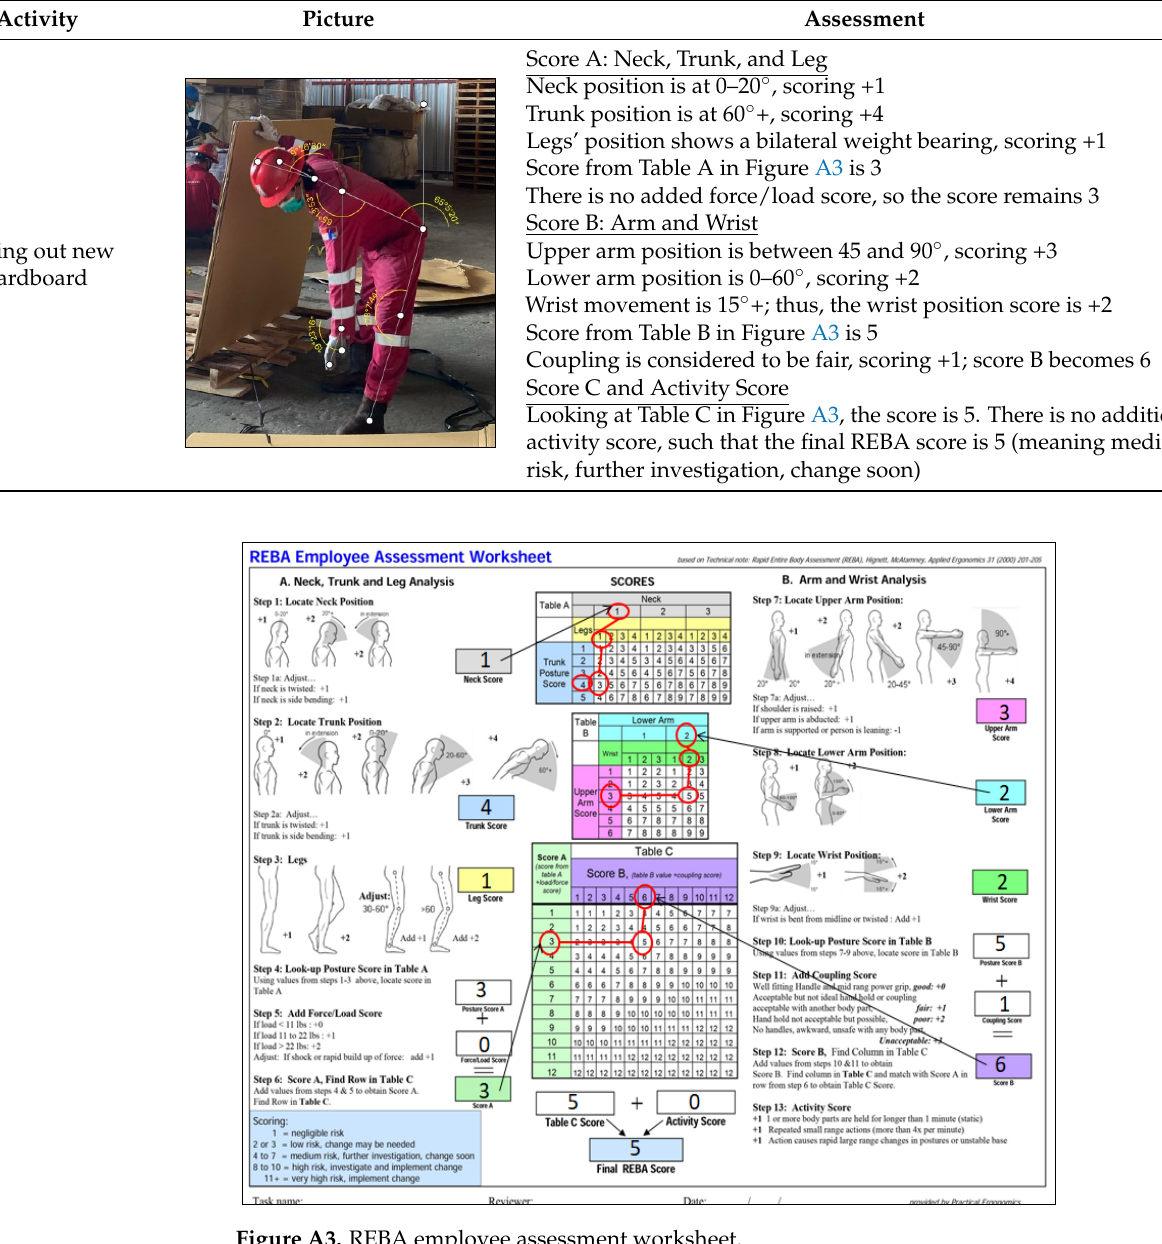
Figure A3. REBA employee assessment worksheet.